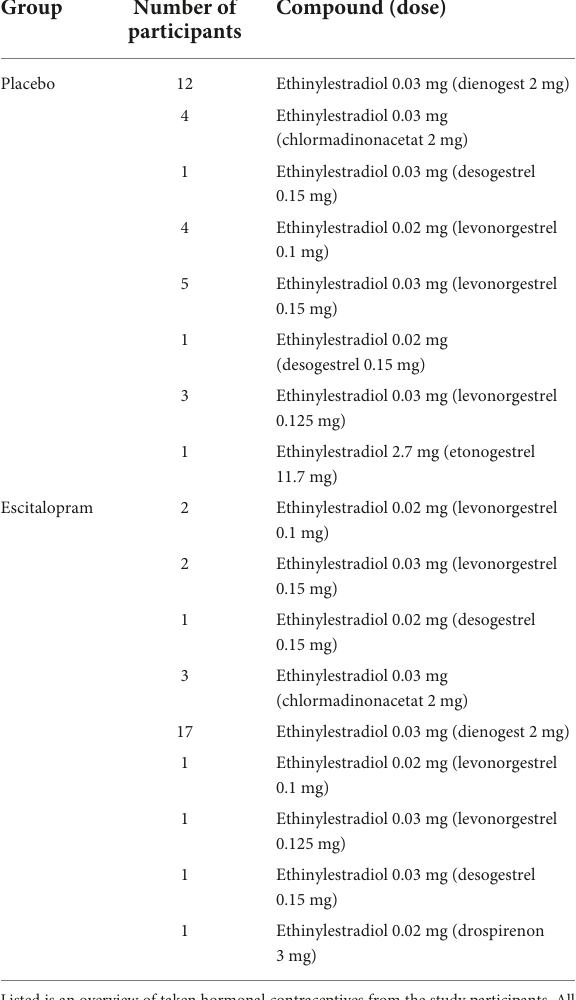
TABLE 2 Contraceptive